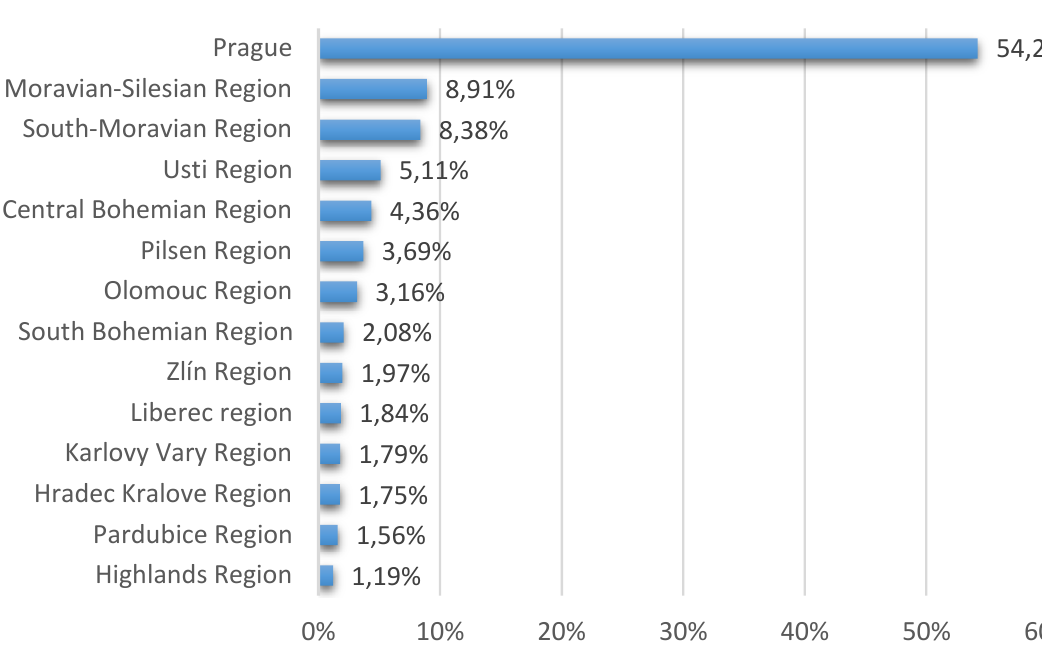
Figure 4: Percentage ratio of individual regions on the real estate market turnover in the Czech Republic in the category of apartments for rent, January 2018 to June 2021 Source: Software